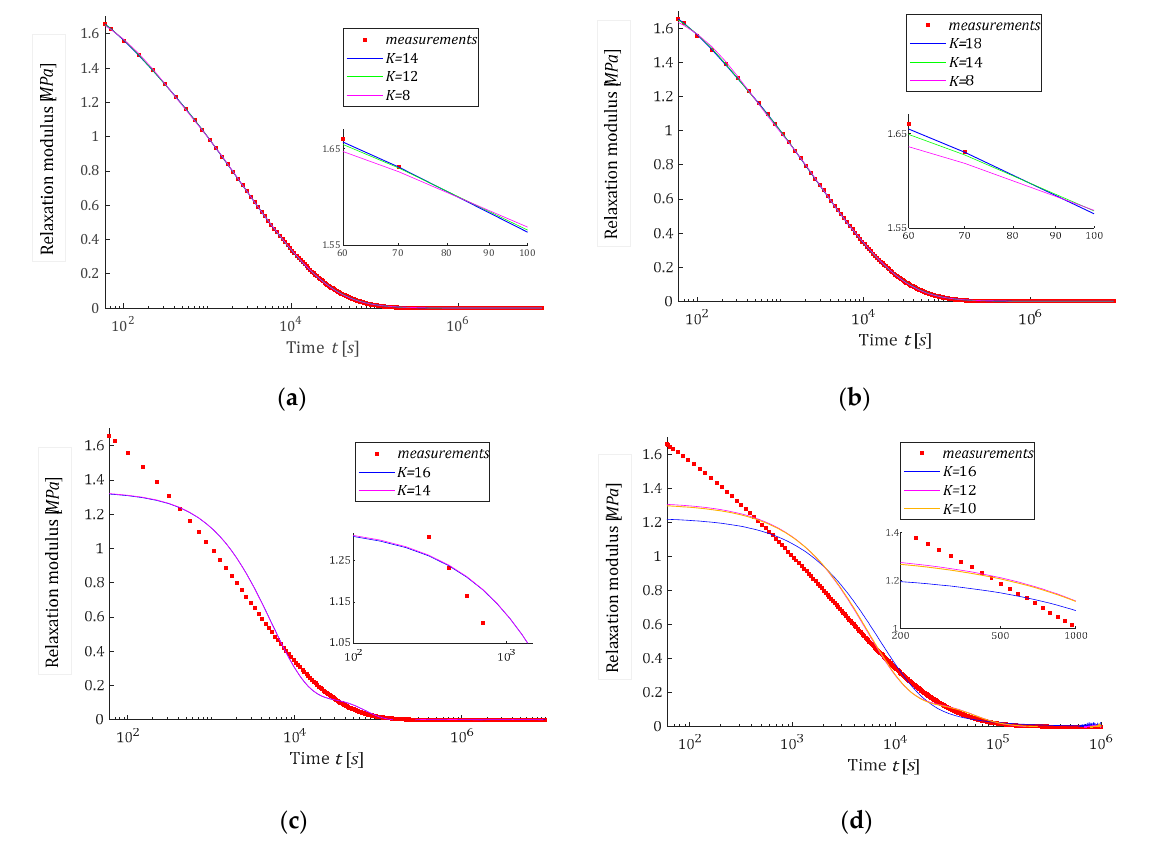
Figure 8. The measurements of the relaxation modulus 𝐺(𝑡) corresponding to the relaxation spec- trum 𝐻 (cid:3014) (𝑣) (61) (red points) from Example 2 and the optimal approximated models 𝐺 (cid:3012) (𝑡) (8): ( a ) Legendre, ( b ) Laguerre, ( c ) Chebyshev, ( d ) Hermite.